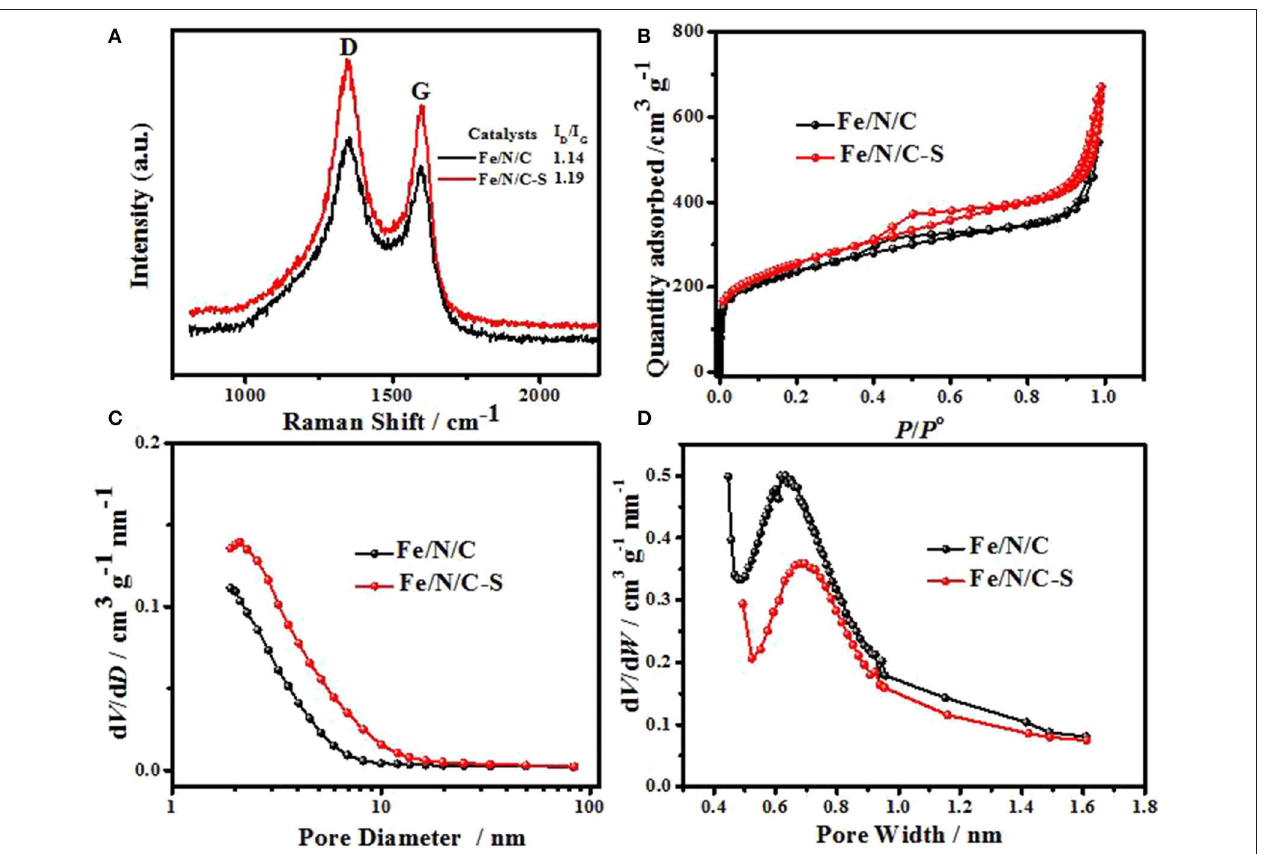
FIGURE 4 | (A) Raman spectra, (B) Ar adsorption and desorption isotherms, (C) mesopore size distribution, and (D) micropore size distribution of Fe/N/C-S and